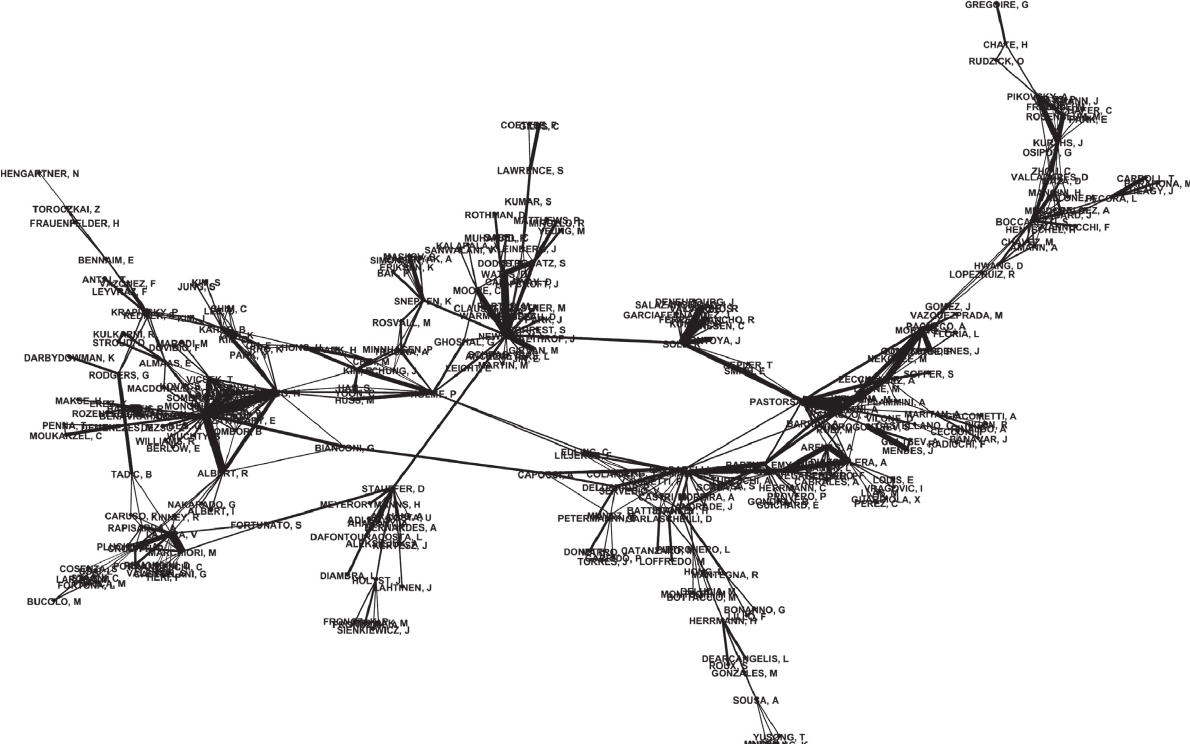
Figure 4: The maximum information transmission path in Coauthor